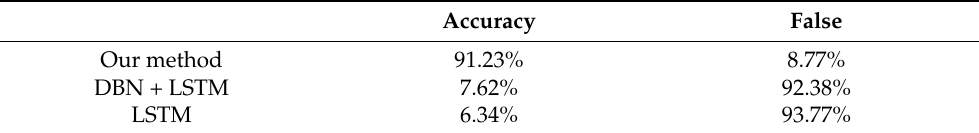
Figure 9. Comparison outcomes between our method and the compared methods through the evaluating indicator. Table 1. Comparison outcomes on our method, DBN + LSTM, and